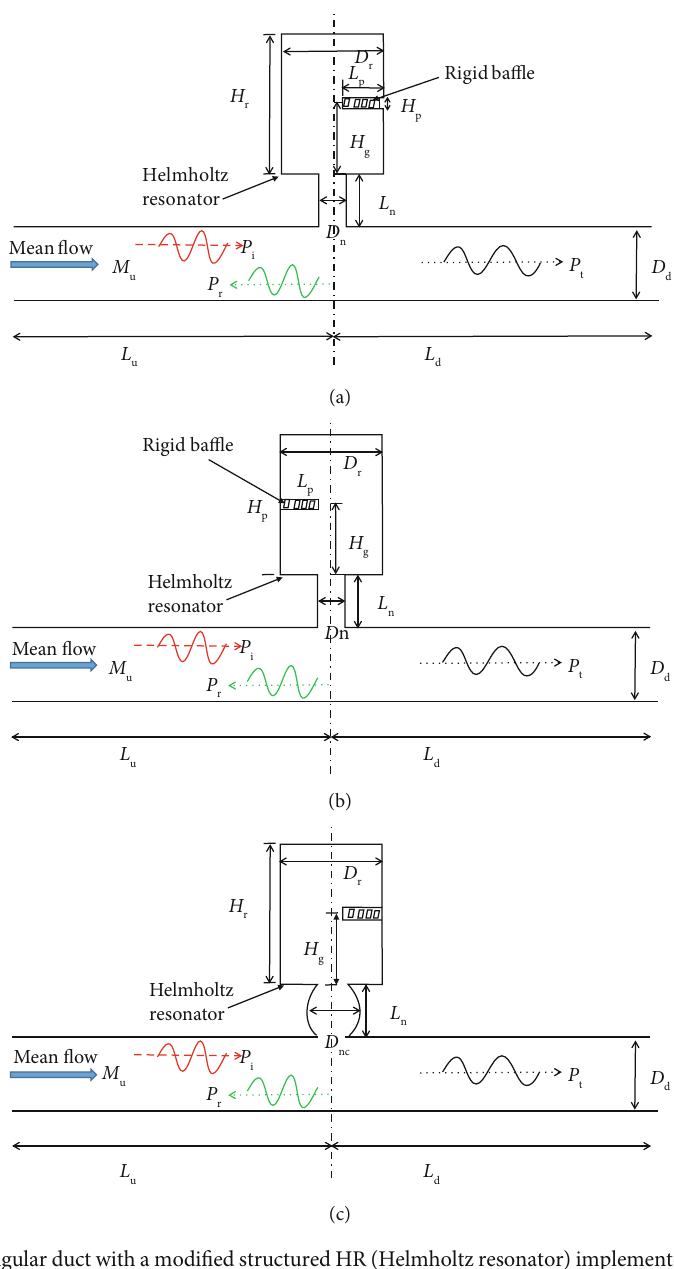
Figure 1: Schematics of a rectangular duct with a modi fi ed structured HR (Helmholtz resonator) implemented in the presence of a mean fl ow (i.e., grazing fl ow). Here, a rigid ba ffl e is implemented in the resonator ’ s cavity to change its aeroacoustic damping performances. (a) con fi guration 1 of the modi fi ed resonator, (b) con fi guration 2 of the modi fi ed resonator, and (c) the modi fi ed resonator with an arc- shaped